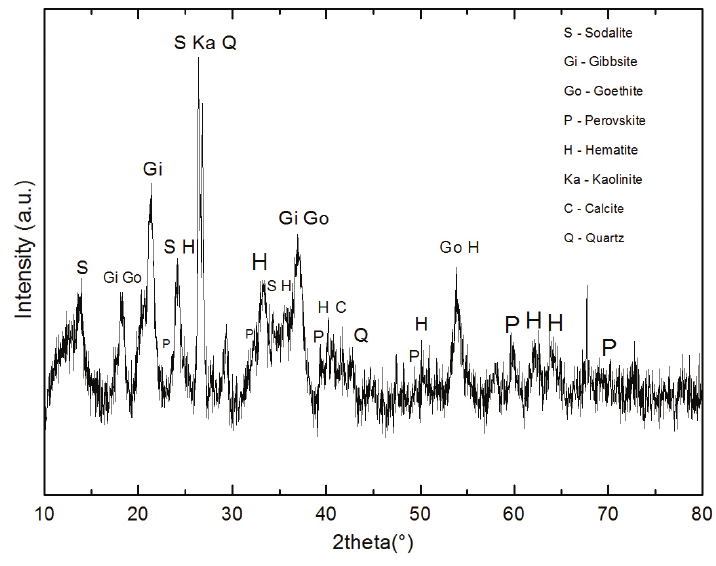
Figure 3. XRD patterns of dried red mud.